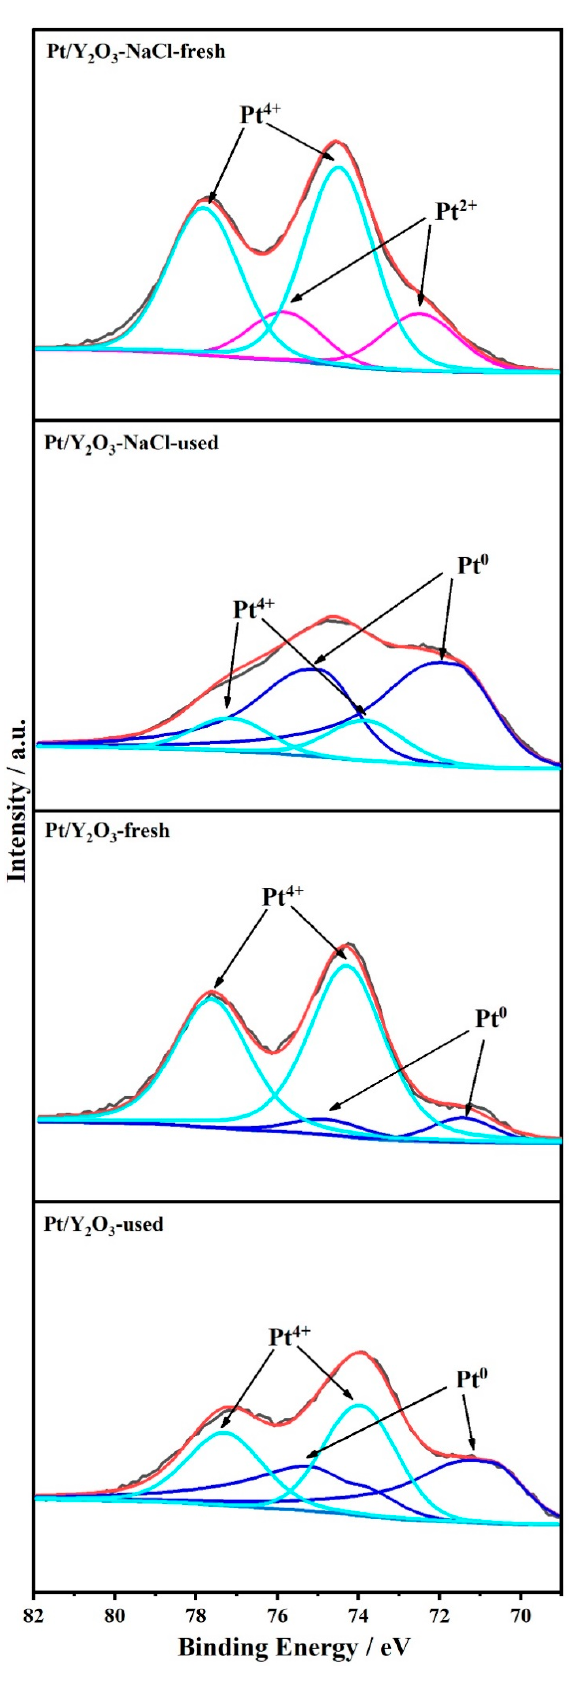
Figure 9. XPS profiles for fresh and used Pt/Y 2 O 3 -NaCl and Pt/Y 2 O 3